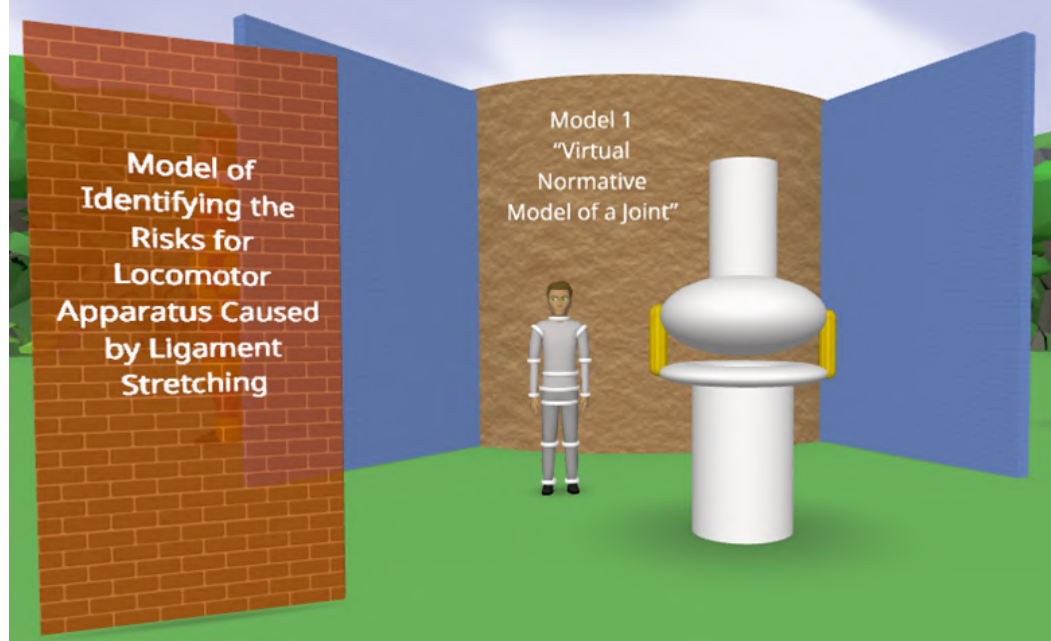
Figure 9: “Virtual Model of Identifying the Risks for Locomotor Apparatus Caused by Ligament Stretch- ing”: Model 1 – “Virtual Normative Model of a Joint”